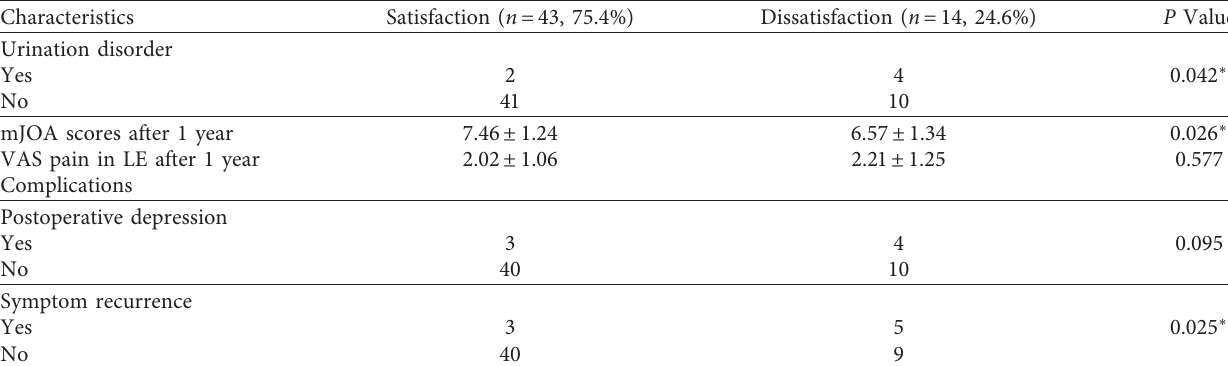
Table 6: The related risk factors of satisfied and dissatisfied patients at 1-year